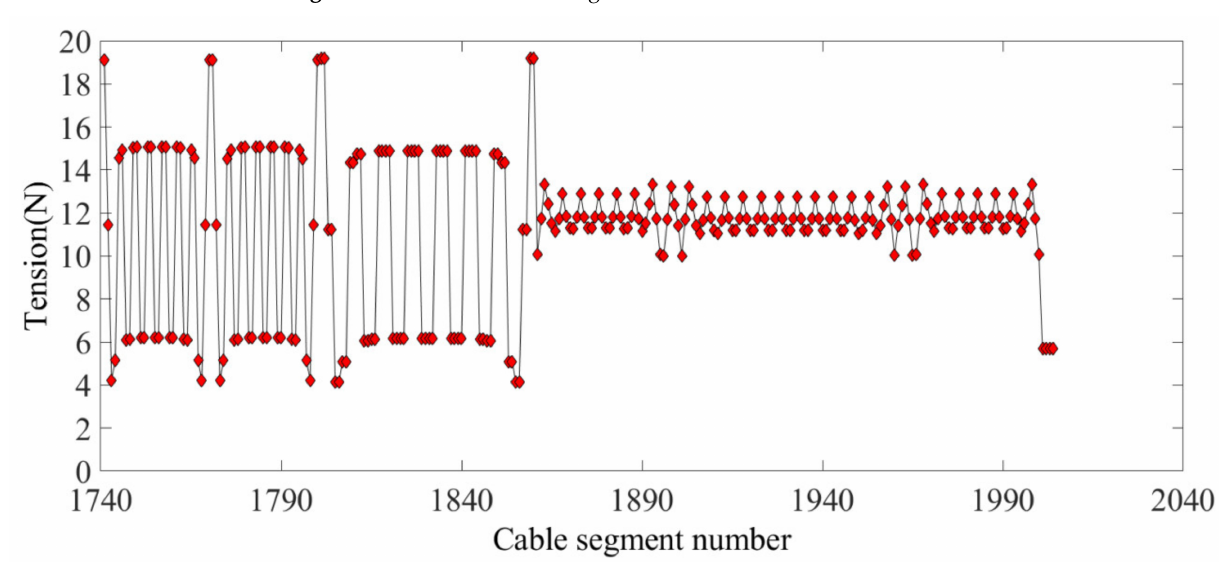
Figure 7. The boundary cable segment